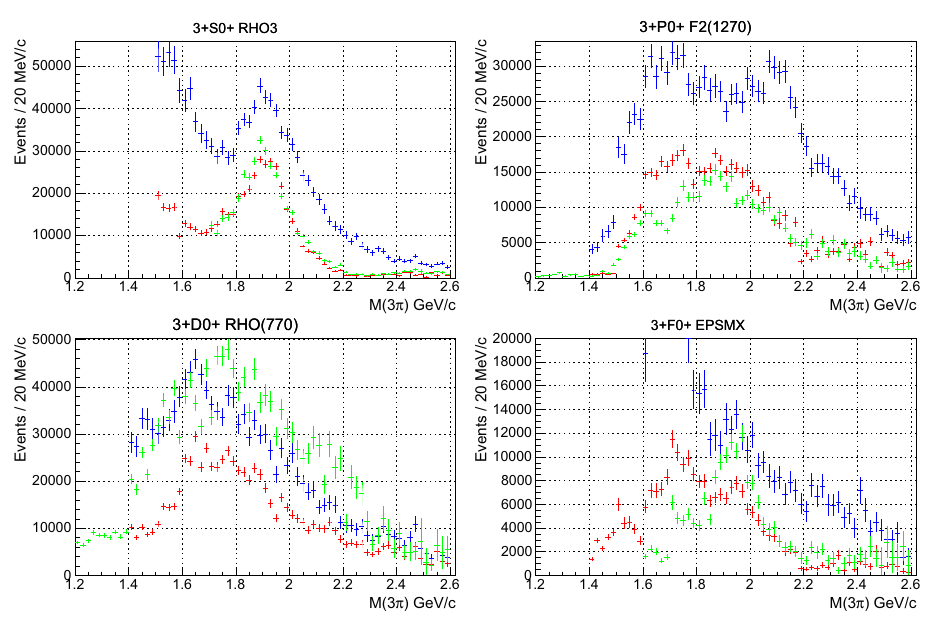
Figure 3. For the system π − 2 π 0 intensities of waves a) 3 + S 0 + ρ 3 (1690) π b) 3 + P 0 + f 2 (1270) π c) 3 + D 0 + ρ (770) π d) 3 + F 0 + επ